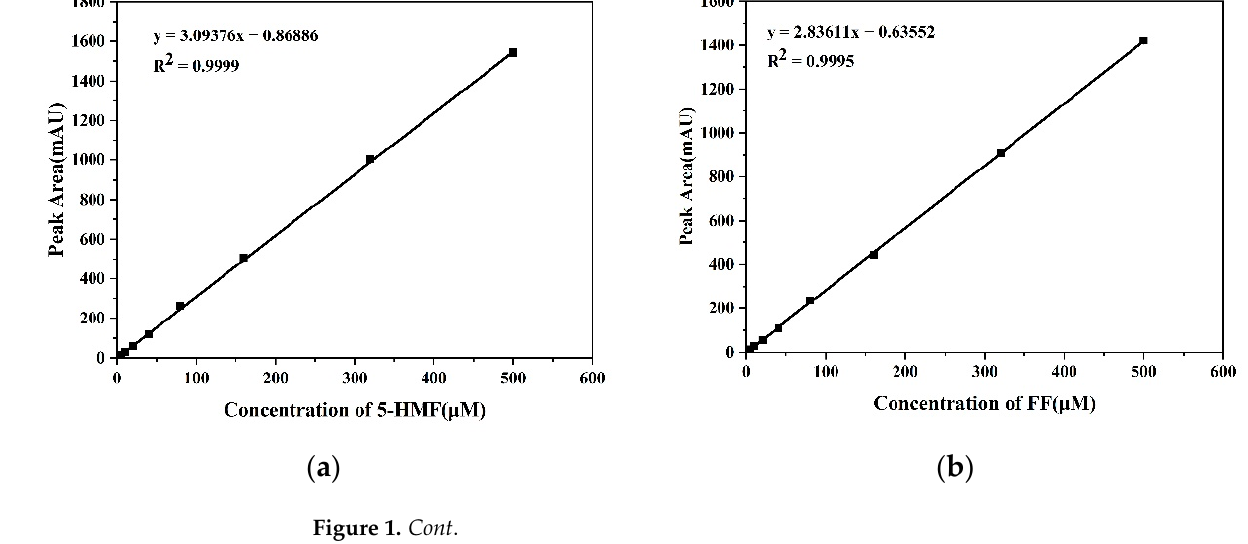
( d ) Figure 1. Concentration changes in 5-HMF and FF detected by HPLC. ( a ) Standard curve of 5-HMF; ( b ) Standard curve of FF; ( c ) Variation of 5-HMF at different concentrations with time; ( d ) Variation of FF at different concentrations with time. *** p < 0.001 vs. 1 day. 3.2. The Determination of LD 50 and Developmental Observations We detected the development of zebrafish embryos exposed to different concentra- tions of 5-HMF for 120 h. At the concentration of 3200 μ M, all the zebrafish larvae died and deformed. At the same time, the mortality and deformity rate of zebrafish embryos increased with the increase in exposure concentration in a concentration-dependent man- ner (Figure 2a,b). The LC 50 value of zebrafish embryos exposed to 5-HMF was 961 μ M for 120 h, and the 95% confidence interval was [656,1365]. High concentrations of 5-HMF ex- posure can cause developmental toxicity to zebrafish embryos, resulting in spinal bend- ing, pericardial edema, and delayed absorption of yolk sac (Figure 2c). In addition, the body length growth of zebrafish larvae was inhibited in the 100 and 400 μ M groups, and they had relatively few deformities (Figure 2d).